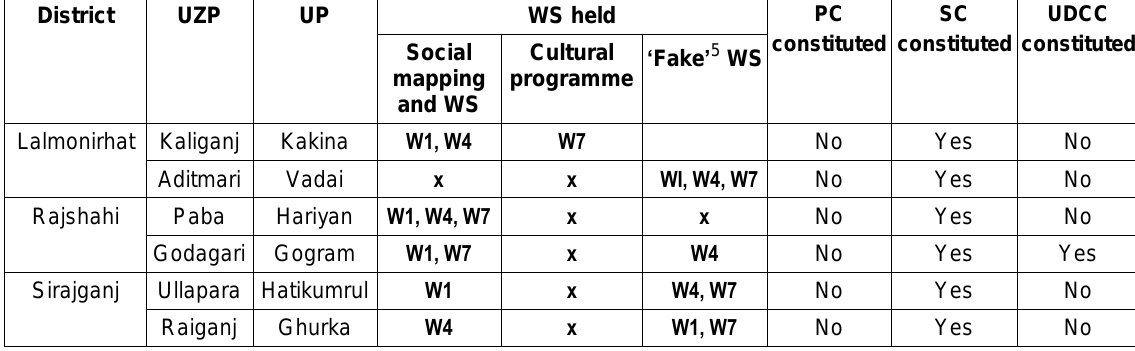
Table 3: Types of PP and PB processes observed in the six UPs studied District UZP UP WS held PC